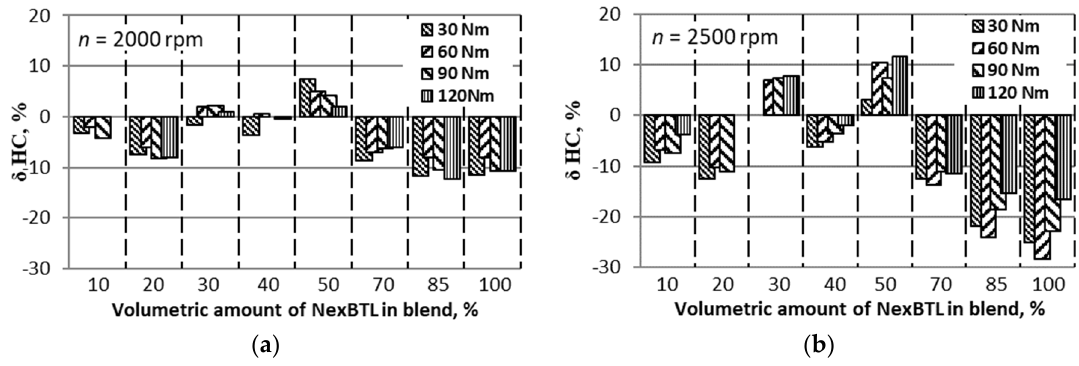
Figure 12. Relative deviation of HC: ( a ) n = 2000 rpm; ( b ) n = 2500 rpm.